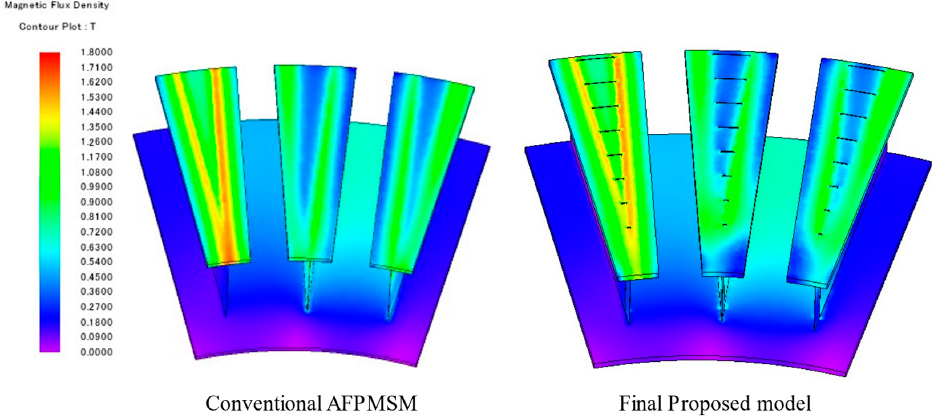
Figure 9. Magnetic flux density comparison between the conventional AFPMSM and the proposed